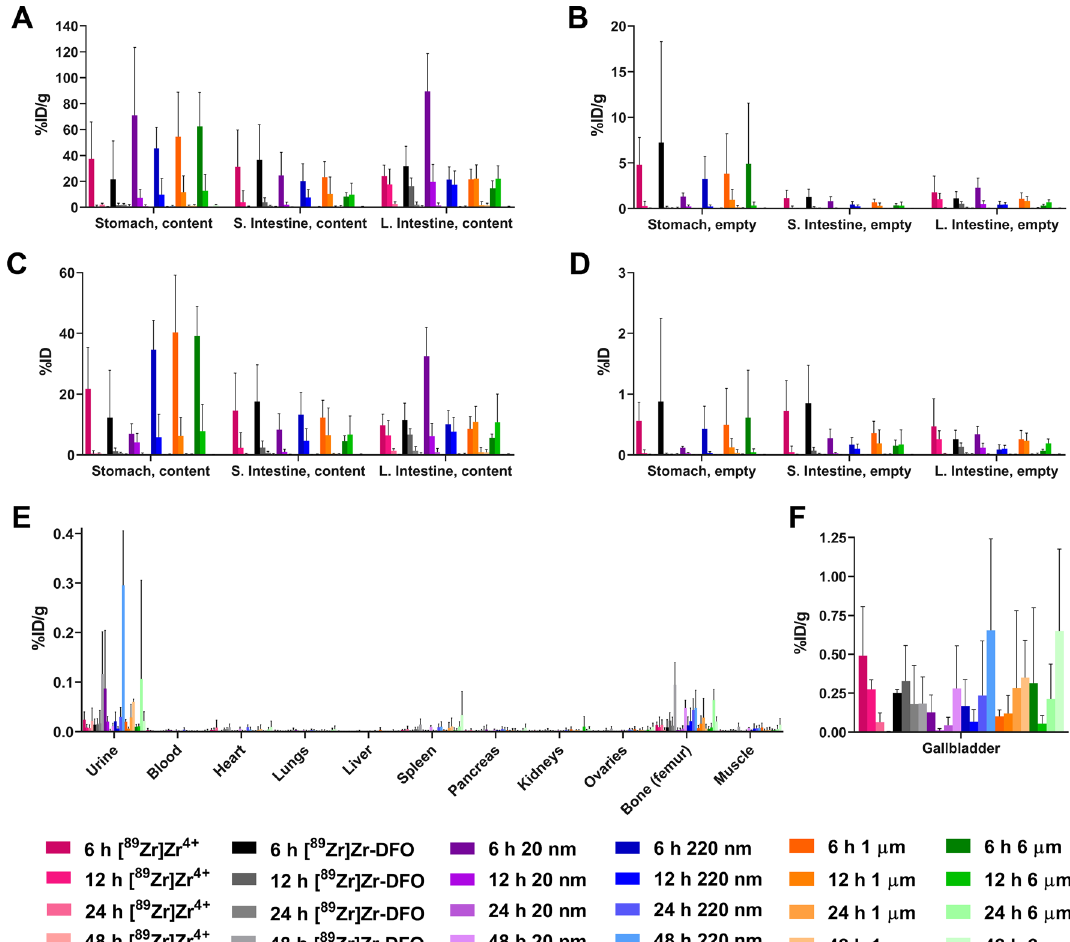
Figure 5. Ex vivo biodistribution data acquired after the oral administration of [ 89 Zr]Zr 4+ , [ 89 Zr]Zr-DFO, and four sizes of [ 89 Zr]Zr-DFO-PS particles (20 nm, 220 nm, 1 μm, and 6 μm). ( A,B ) %ID/g data for the gastrointestinal tract; ( C,D ) %ID data for the gastrointestinal tract; ( E ) %ID/g data for organs other than gastrointestinal tract and gallbladder; ( F ) %ID/g data for the gallbladder. The data are presented as mean ± standard deviation. S. Intestine = Small Intestine. L. Intestine = Large Intestine. Numerical biodistribution data can be found in Tables S2-S13